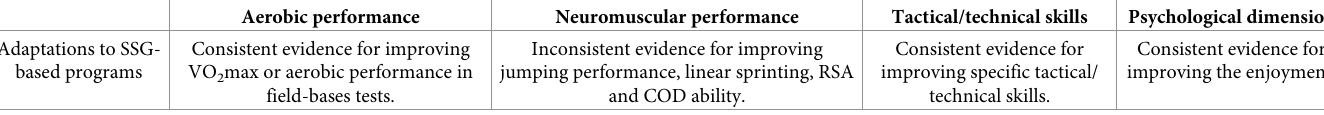
Table 4. Longer-term adaptations to SSG-based programs: Summary